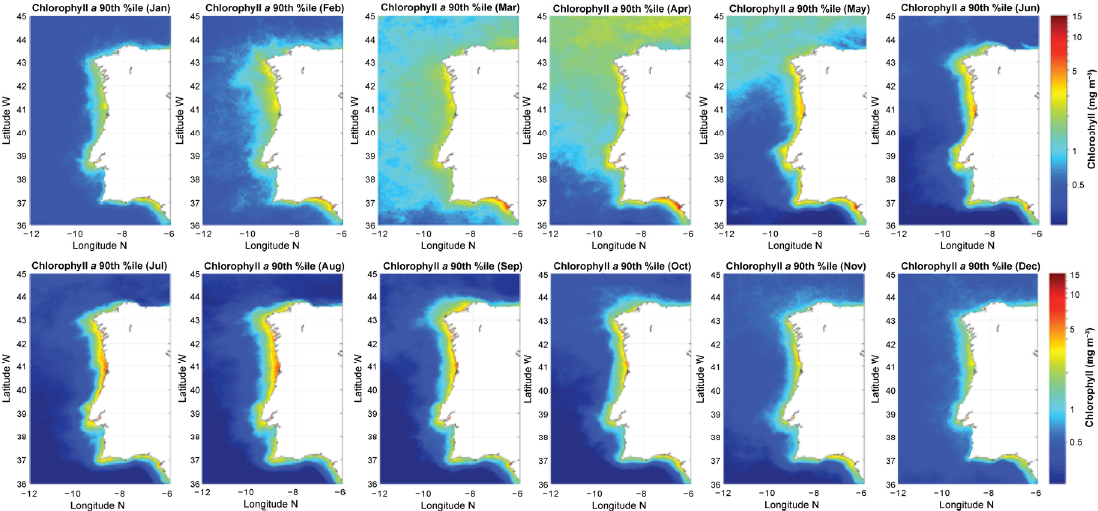
Figure 6. Satellite Chl a P90 monthly climatologies at the Western Iberia region, from CCI data products (1998–2016; mg m − 3 ).